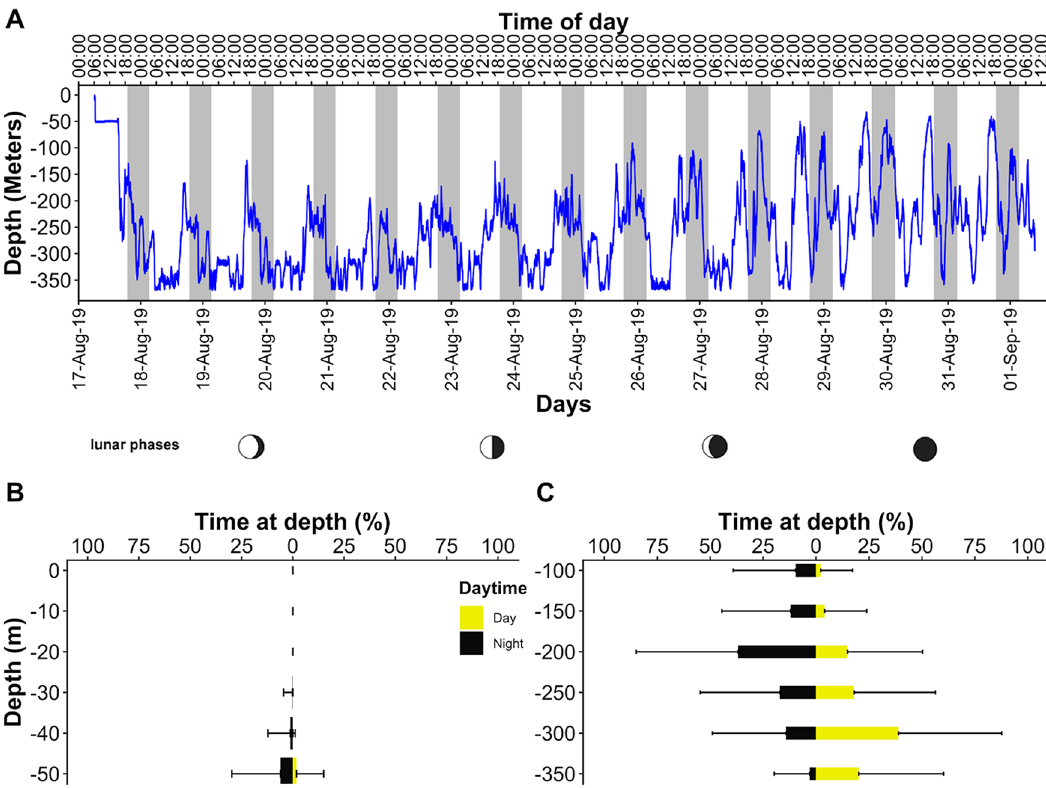
Fig. 4. Graphic representation of predator vertical movement. (A) Predator diving behaviour by date (days), time (h) and lunar phases between 17th of August 2019 and 1st of September 2019. Blue line = dive pro fi le, grey area = nautical twilight night event (time between dusk and dawn) and white area = nautical twilight day event (time between dawn and dusk) (bB) percentage of Time at Depth (TAD) bar plot. Depth bins = 0 (thresholds 0 – 9 m), 10 (thresholds 10 – 19 m), 20 (thresholds 20 – 29 m), 30 (thresholds 30 – 39 m), 40